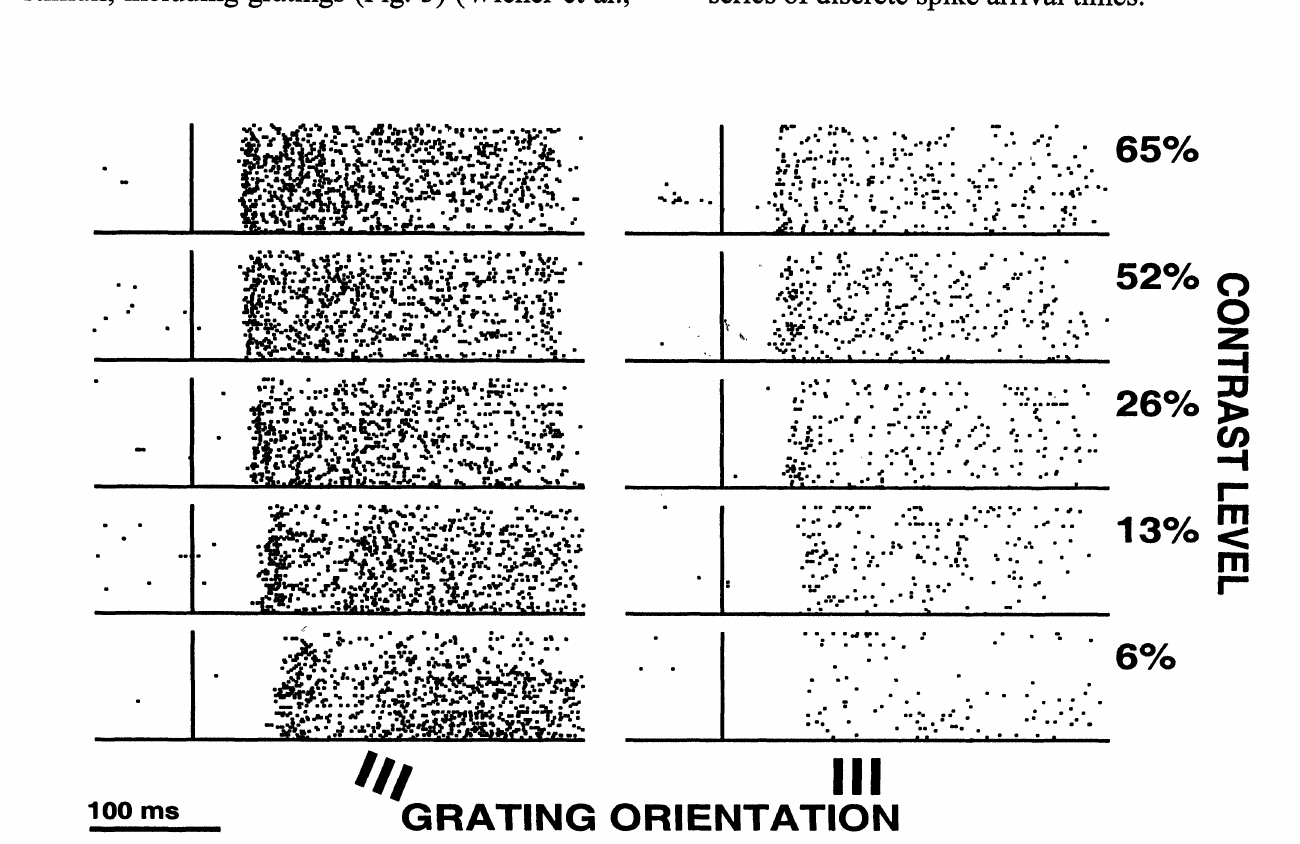
Fig. 3: Responses elicited by gratings of several contrasts at optimal and nonoptimal orientations from a V1 complex cell. There are substantial changes in response strength induced by changes in orientation, whereas the latency changes by, at most, a small amount. The latencies become substantially longer (-30 ms in this example) as the contrast decreases. The minimum latency at each contrast is the same at both orientations. The response elicited by the lowest contrast optimally oriented grating is large with a long latency (bottom left column) whereas the response elicited by another grating is weak and has a short latency (top right column). Thus, latency and response strength are